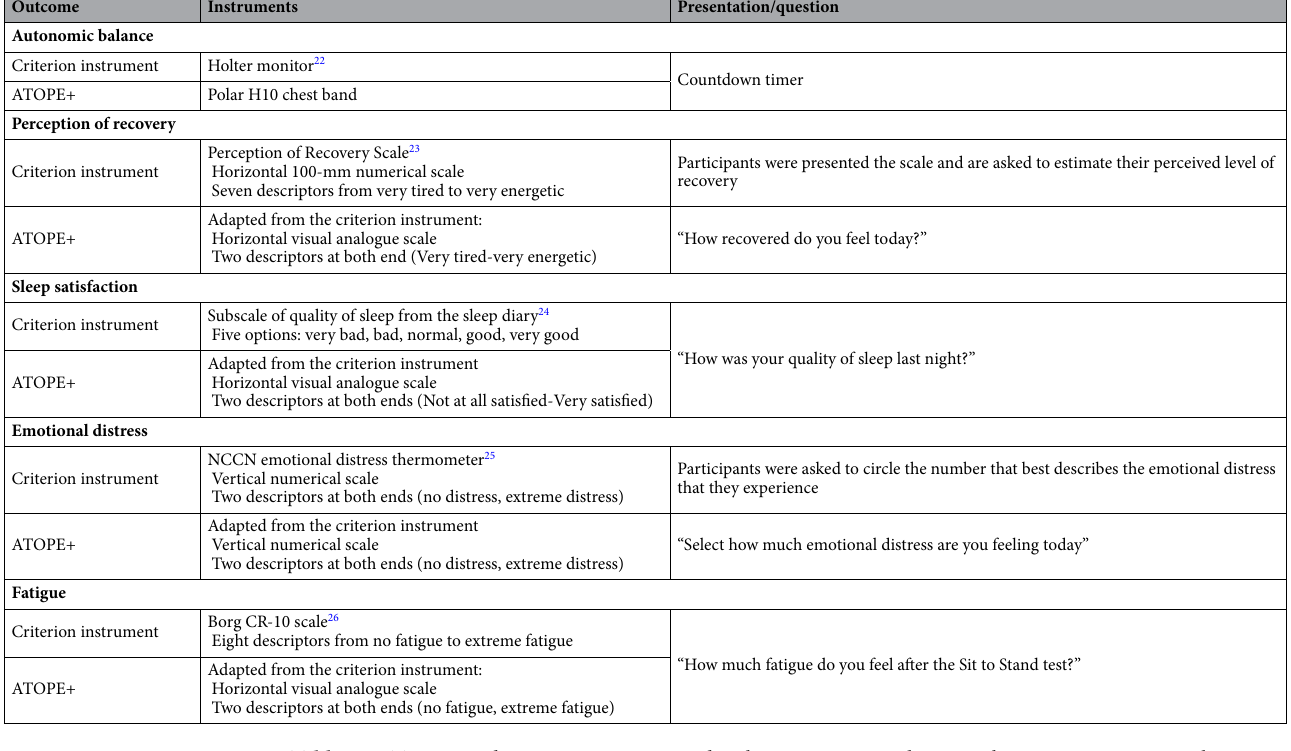
Table 1. ATOPE+ and criterion instruments details. NCCN National Comprehensive Cancer Network; LNRMSSD mean square root differences of the standard deviation; STS Sit to Stand